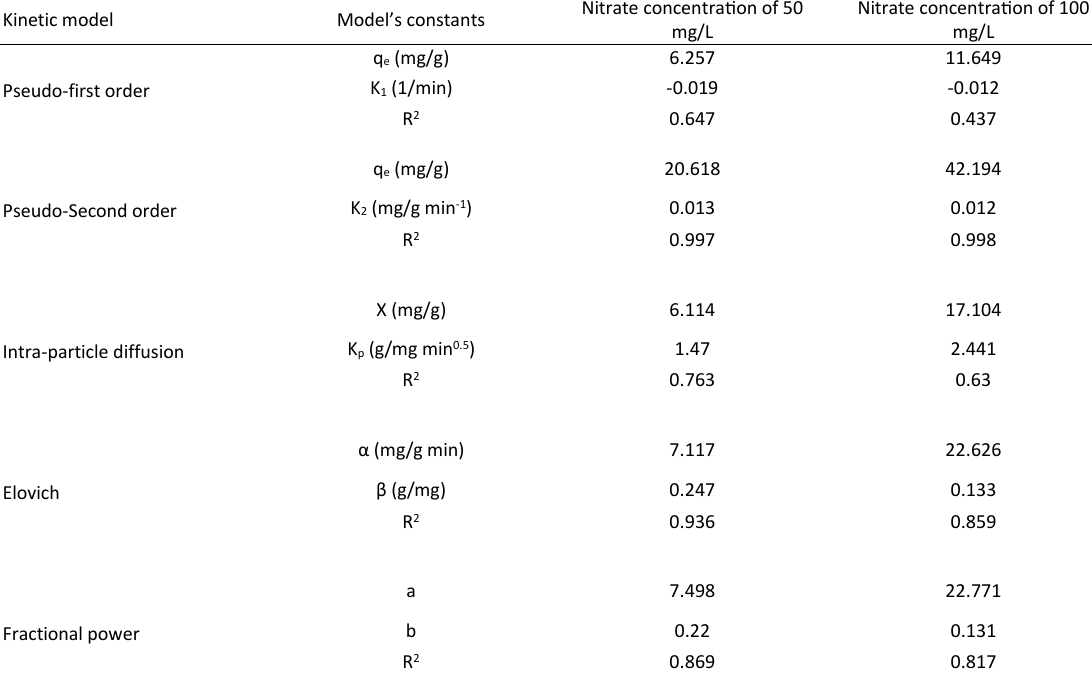
Table 3: Results of data fitness to the kinetic models of nitrate adsorption on Mg-Al-LDH (4:1) in two initial nitrate concentrations (50 and 100 mg/L)